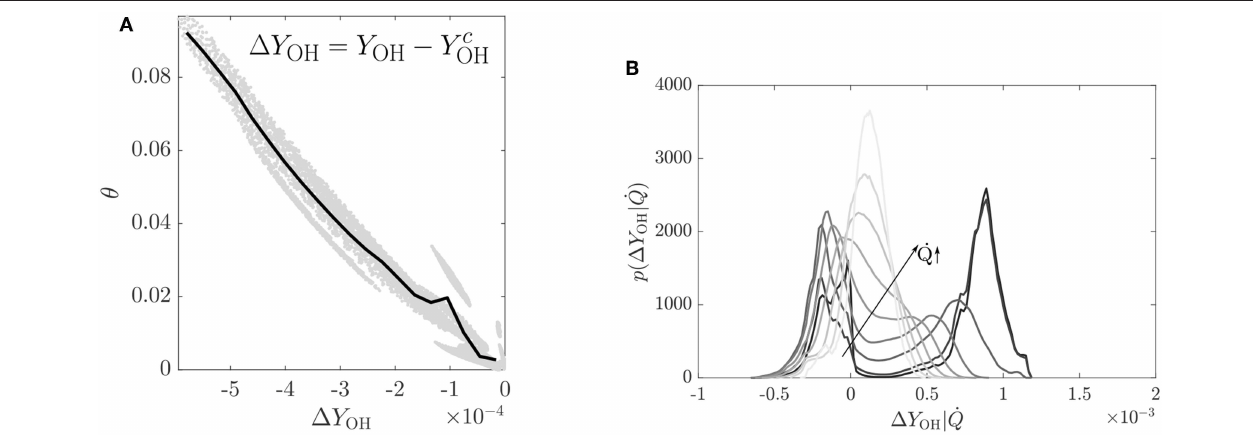
N Z > 0.2 at an arbitrarily chosen time for the case b